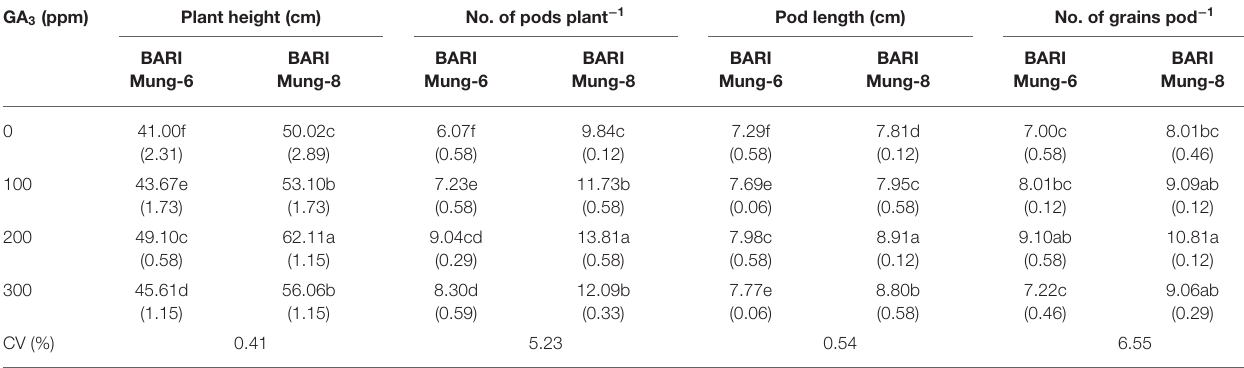
TABLE 7 | Effect of GA 3 on the plant height (cm), pods plant − 1 , pod length (cm), and grains pod − 1 of V. radiata varieties. GA 3